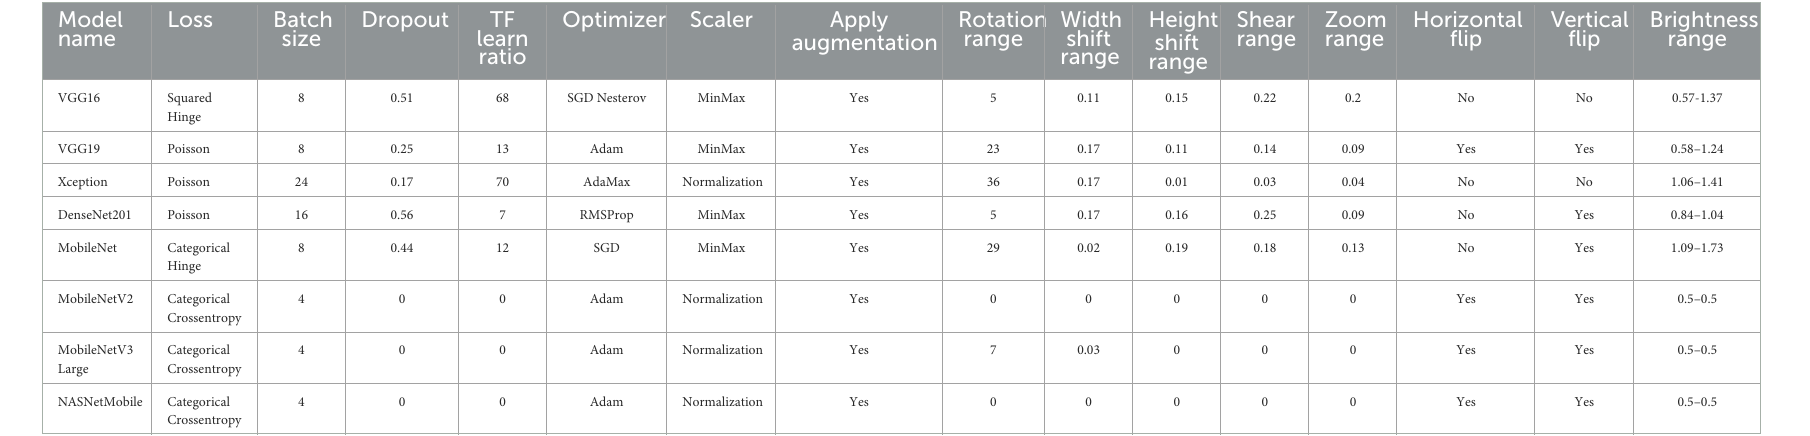
TABLE 14 After the LOP, the best solutions for the Five-classes dataset.